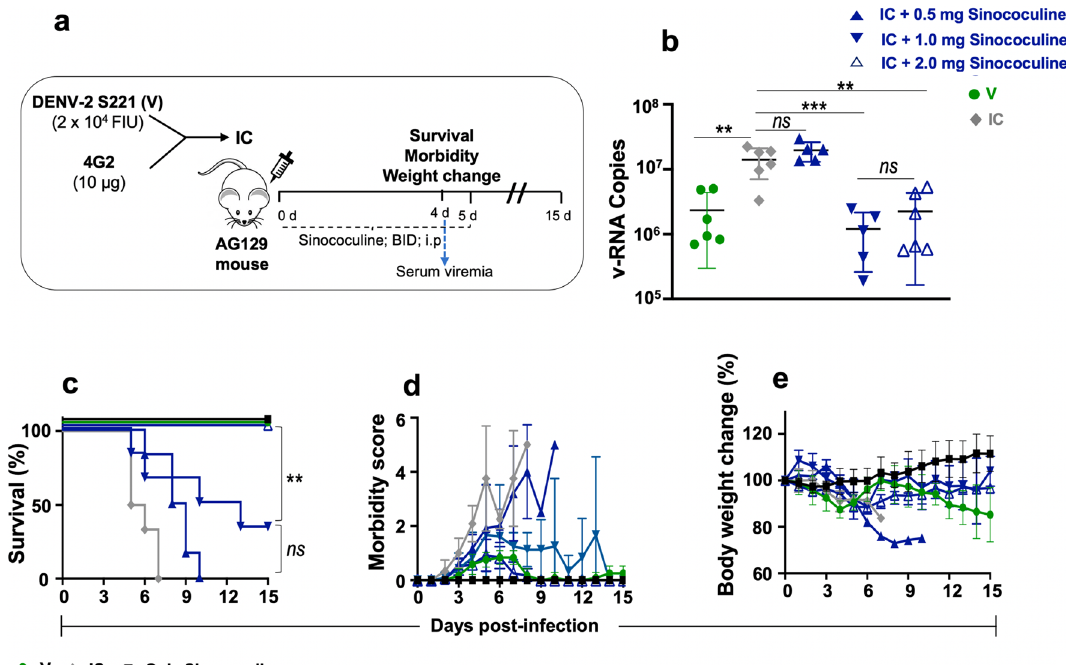
Figure 3. Evaluation of protective efficacy of Sinococuline in severely DENV-infected AG129 mouse model. ( a ) Pictorial representation of study design. Group of AG129 mice (n = 6) were infected with Immune complex (IC) of DENV-2 S221 and 4G2 mAb, thereafter, mice were intraperitonially (i.p) injected with three doses of Sinococuline viz ., 0.5 mg/kg/day (solid blue upward triangle), 1.0 mg/kg/day (solid blue downward triangle) and 2.0 mg/kg/day (empty blue upward triangle) in a twice a day (BID) dosing regimen for 5 days, and all mice were monitored for 15 days post-infection for their survival ( c ), morbidity ( d ) and body weight change ( e ). On day 4 post-infection, 50 µl of bleed were collected from each mouse for the estimation of serum viremia by performing the RT-qPCR ( b ). Control groups across all the panels were: V, mice infected with sublethal dose of virus (green circle); IC, mice inoculated with immune complex (grey diamond); only Sinococuline, the mice who were neither infected with V nor IC but injected with highest dose of Sinococuline (2.0 mg/kg/day; solid black square). To nurse all the mice similarly, both V and IC (vehicle/placebo) groups were administered i.p with 1x PBS, BID instead of Sinococuline for 5 days. Serum viremia data (panel ‘ b ’) was statistically evaluated by using Two-way ANOVA with Tukey’s Multiple comparisons test, where, ns : not significant (p > 0.05); ***very significant ( p = 0.0008), **significant ( p = 0.0013), represented on top of the data, denote statistical differences between different treated and non-treated groups. However, survival data (panel ‘ c ’) was analysed by Long-rank (Mantel–Cox) test, where ns : not significant ( p > 0.05); **statistically significance ( p = 0.0183), represented on right side of the survival graph, indicate statistical differences between the